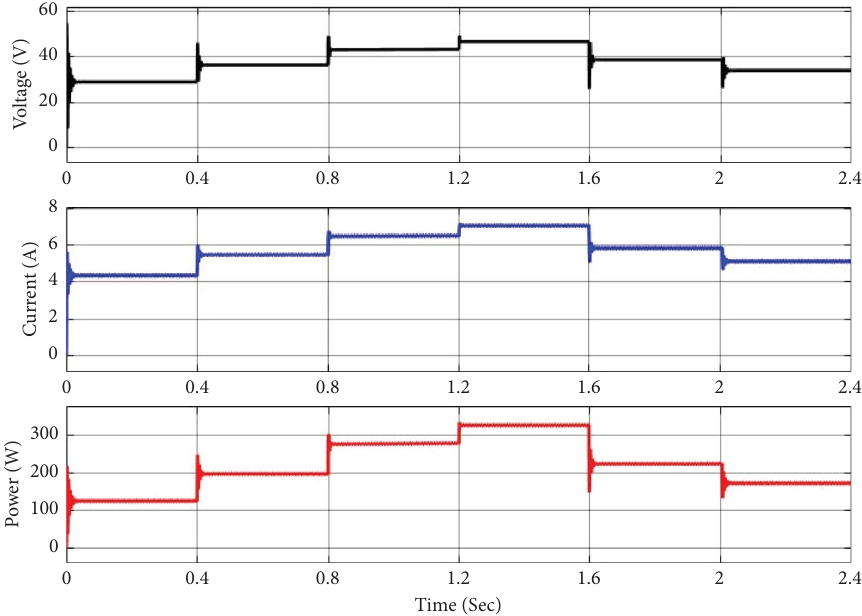
Figure 19: Input voltage, current, and power at Converter-2.